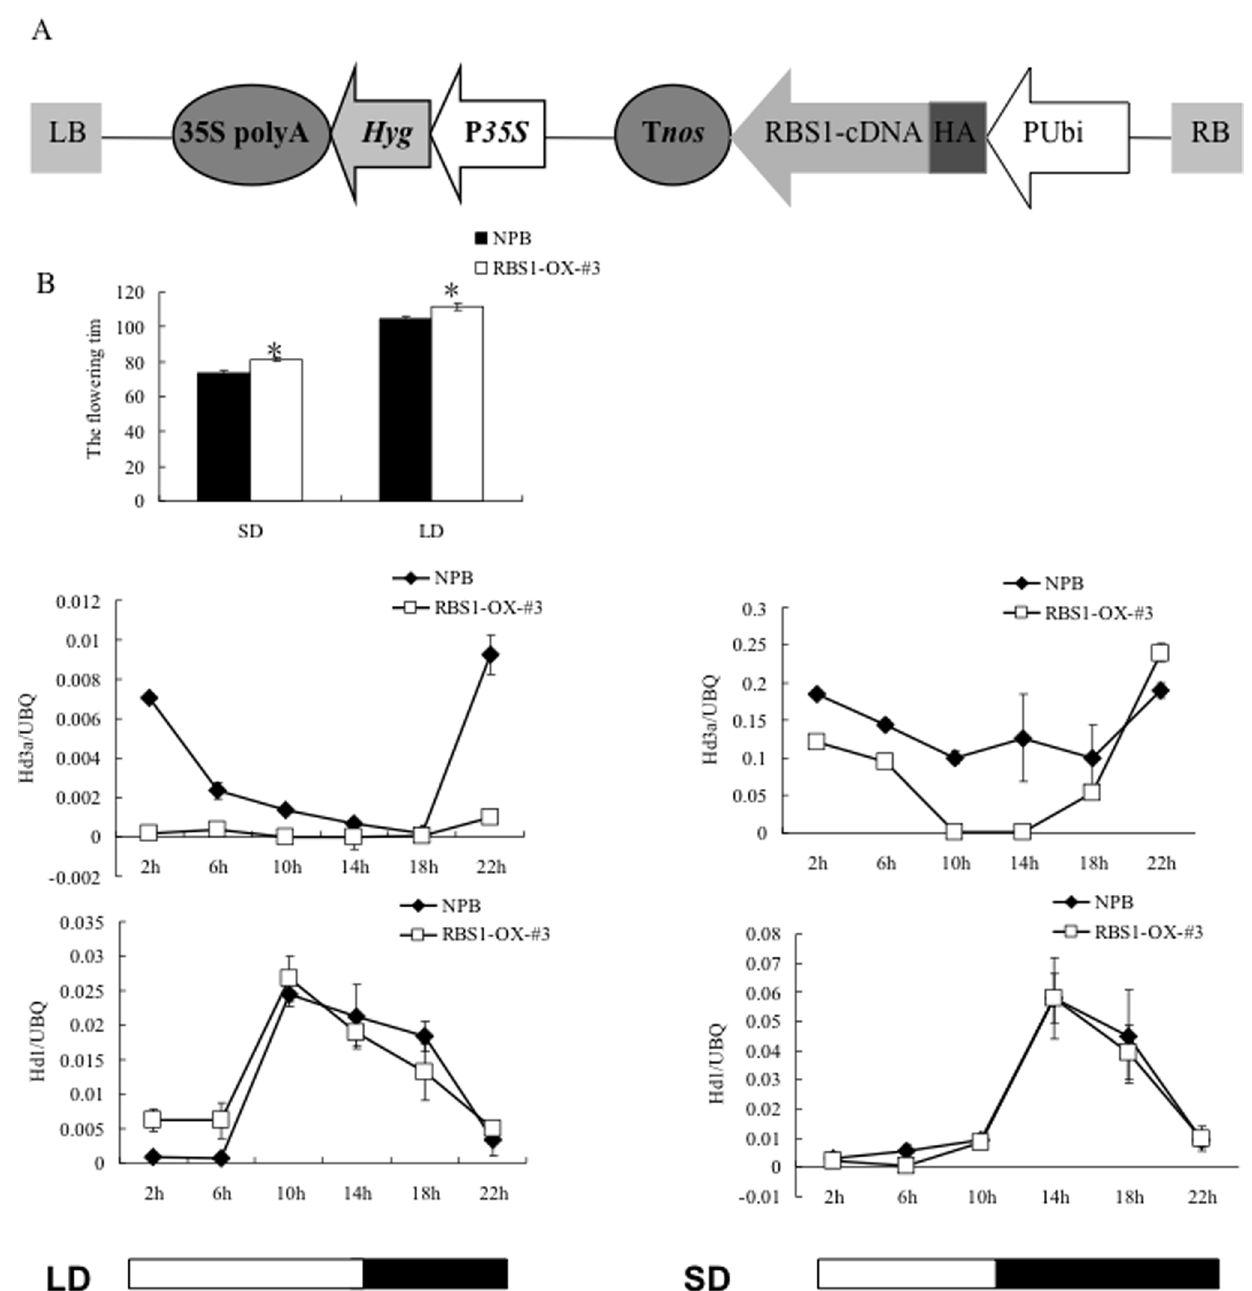
Figure 5. Flowering time of the Rbs1 overexpression plants and the expression pattern of flowering marker genes under SD and LD conditions. (A) Schematic diagram of the Rbs1 overexpression construct. The Rbs1 cDNA sequence fused with the HA tag is placed after the maize ubiquitin promoter (B) Flowering time (days) of the Rbs1 overexpression plants and wild type Nipponbare plants (NPB) was measured under SD and LD conditions (C) Real-time PCR analysis of the expression of Hd3a and Hd1 in the Rbs1 overexpression plants and wild type Nipponbare plants under SD and LD conditions. doi:10.1371/journal.pone.0087258.g005 interaction between SPIN1 and RBS1 in rice protoplasts [25,28]. interact in vivo and that the interaction occurs in the nucleus. To No fluorescence signal was detected when NYFP-SPIN1 + CYFP further confirm the interaction in vivo, we performed a co-IP experiment by expressing SPIN-HA and RBS1-RFP fusion or NYFP + CYFP-RBS1 (Figure 3A) were expressed in rice protoplasts, respectively. However, fluorescence was fully recon- proteins in N. benthamiana by agroinfiltration. As can be seen in stituted in the nucleus only when full-length SPIN1 and RBS1 figure 3B, RBS1-RFP co-immunoprecipitated with SPIN-HA. proteins were co-expressed in rice protoplasts as NYFP and CYFP fusions, respectively (Figure 3A), indicating that these proteins